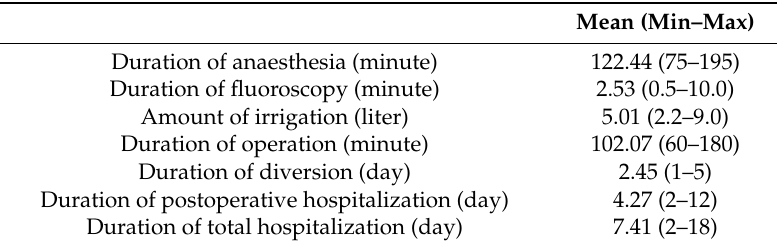
Table 2. Operation and hospitalization parameters of